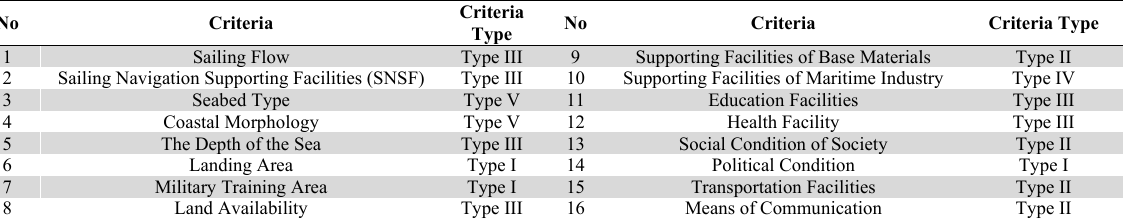
Type of Preference